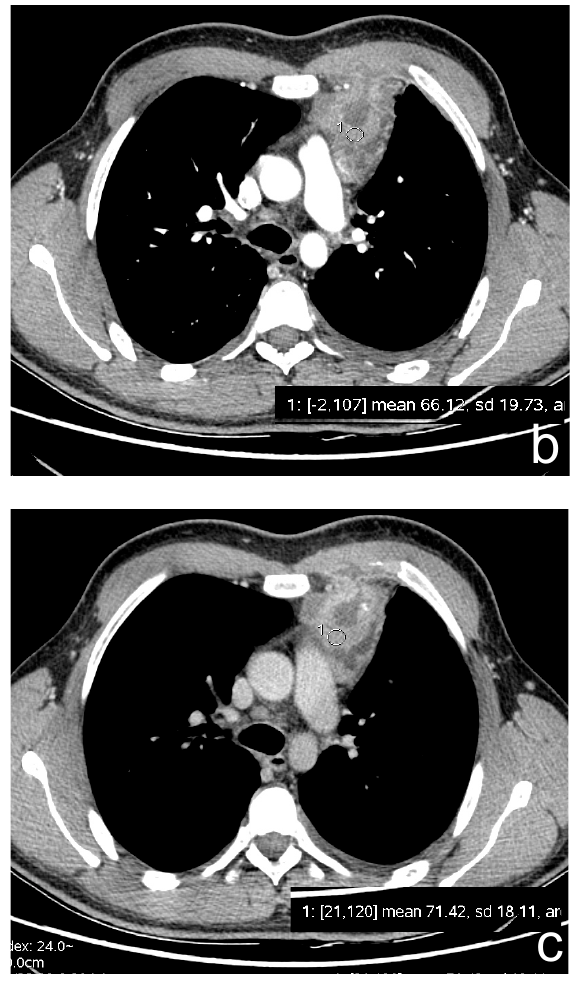
Figure 4. ( a – c ) A 23-year-old man with a partially cystic lesion of the anterior mediastinum. CT scans without contrast ( a ) and after contrast medium administration in arterial ( b ) and delayed (3 min, ( c )) phases show late enhancement peak of the solid component (ROI 1). Surgery revealed a seminoma.